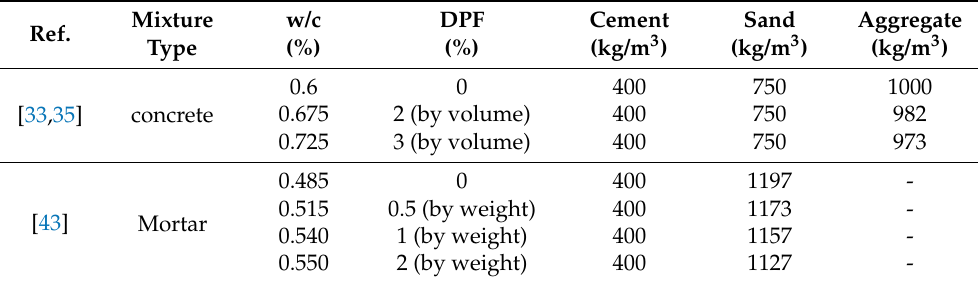
Table 5. Mix proportions of mortars and concretes containing DPF fibers. Table 5. mix proportions of mortars and concretes containing DPF fibers.